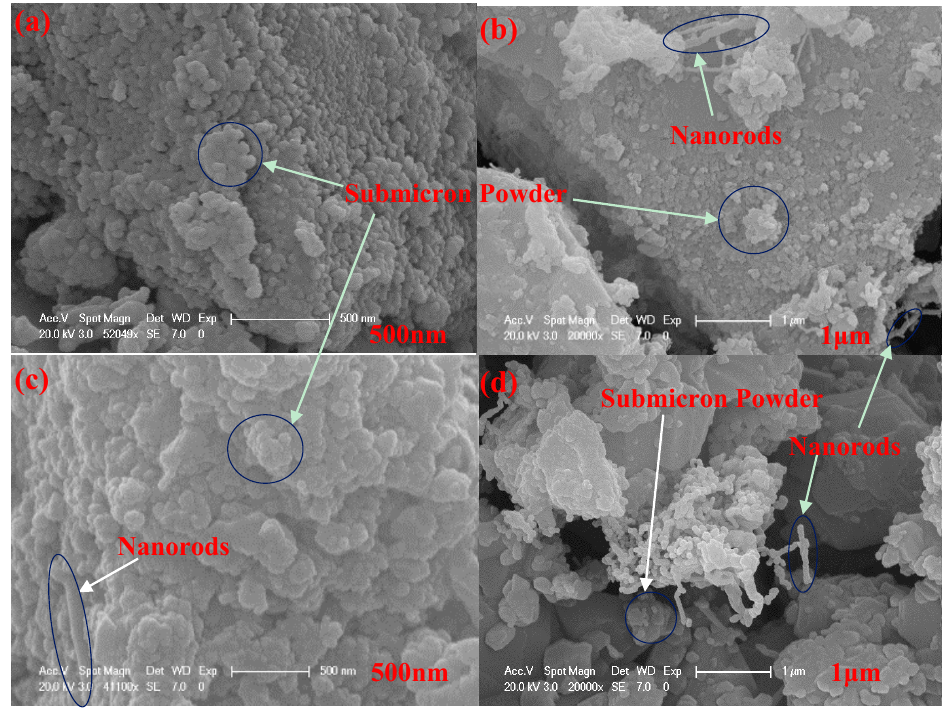
Figure 5. SEM micrographs of A 10 ( a ); B 8 ( b ); D 5 ( c ); C 3 ( d ), showing β -SiC nanorods and submicron powder.